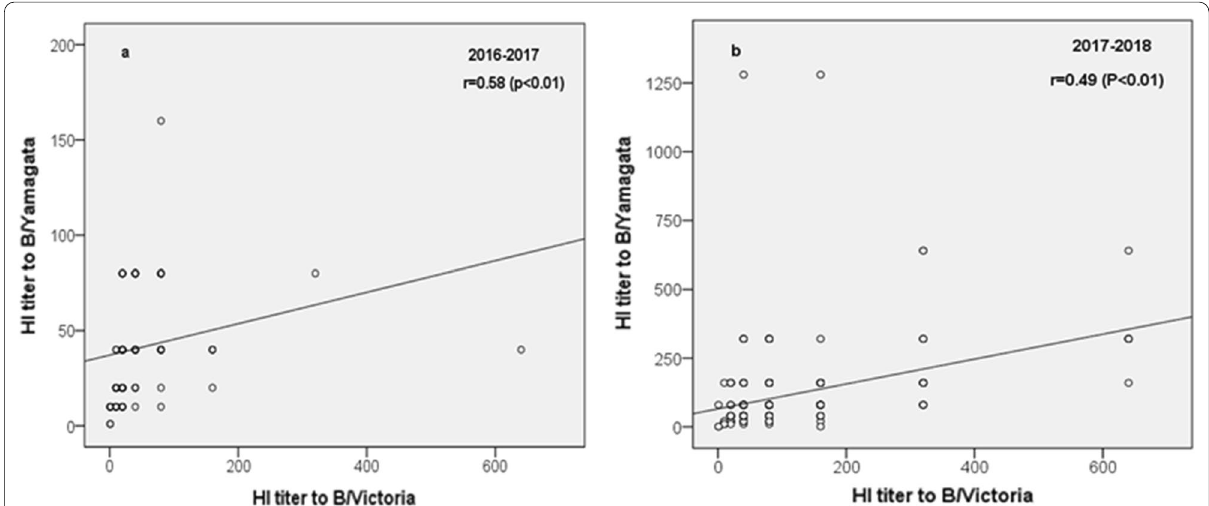
Fig. 2 Comparison of HI titer distributions against two lineages of Flu B viruses by Spearman tests. We can see categories of HI titer to both lineages increased significantly in 2017–2018 than in 2016–2017. Moderate correlation can be found between B/Y and B/V lineage as the HI titers in